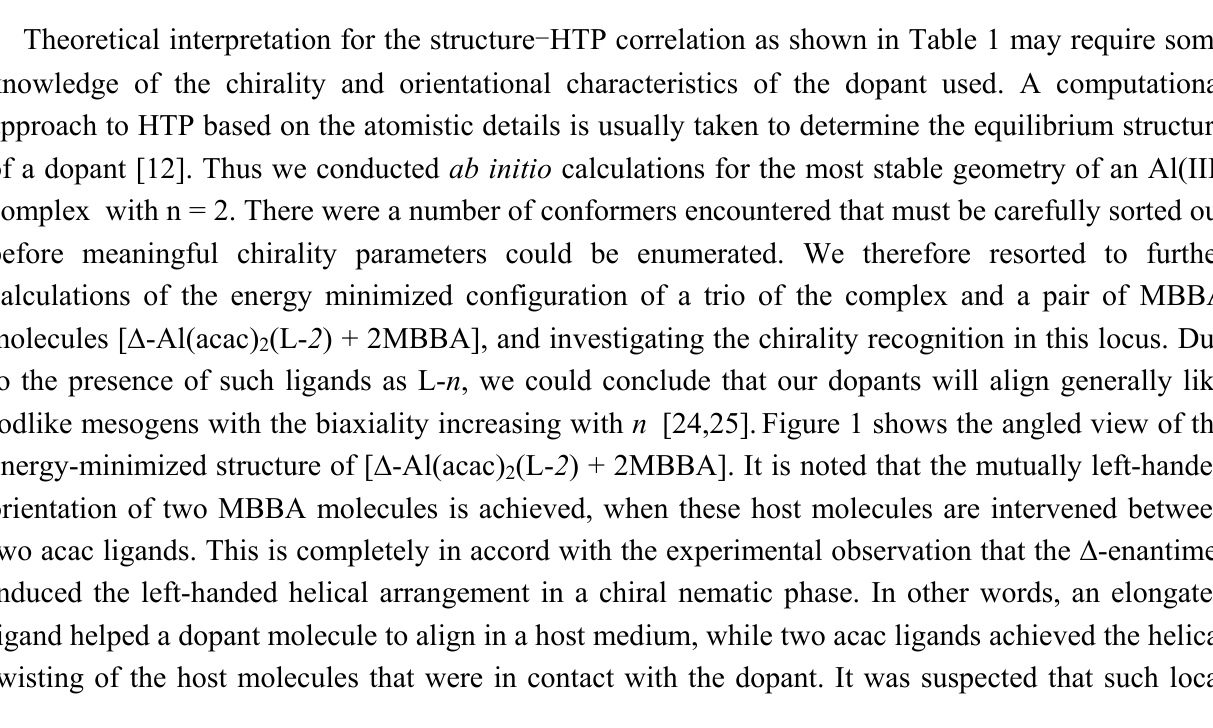
Table 1. Values for HTP ( β